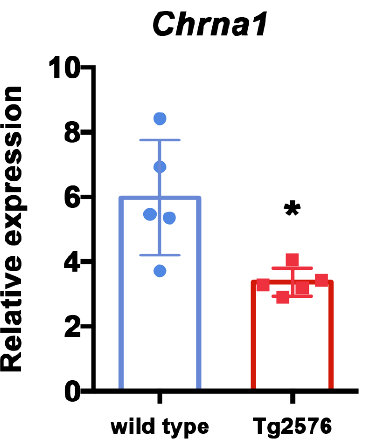
Figure 4. Cholinergic receptor nicotinic alpha polypeptide 1 (Chrna1) is down-regulated in skeletal muscle of Tg2576 mice. Expression analysis of Chrna1, by qRT-PCR, on TA muscles derived from 6-month-old female wild type and Tg2576 mice. Data are reported as relative to housekeeping gene TBP, and represented as mean ± SEM ( n = 5 mice); unpaired t test was used for comparison (* = p < 0.05).